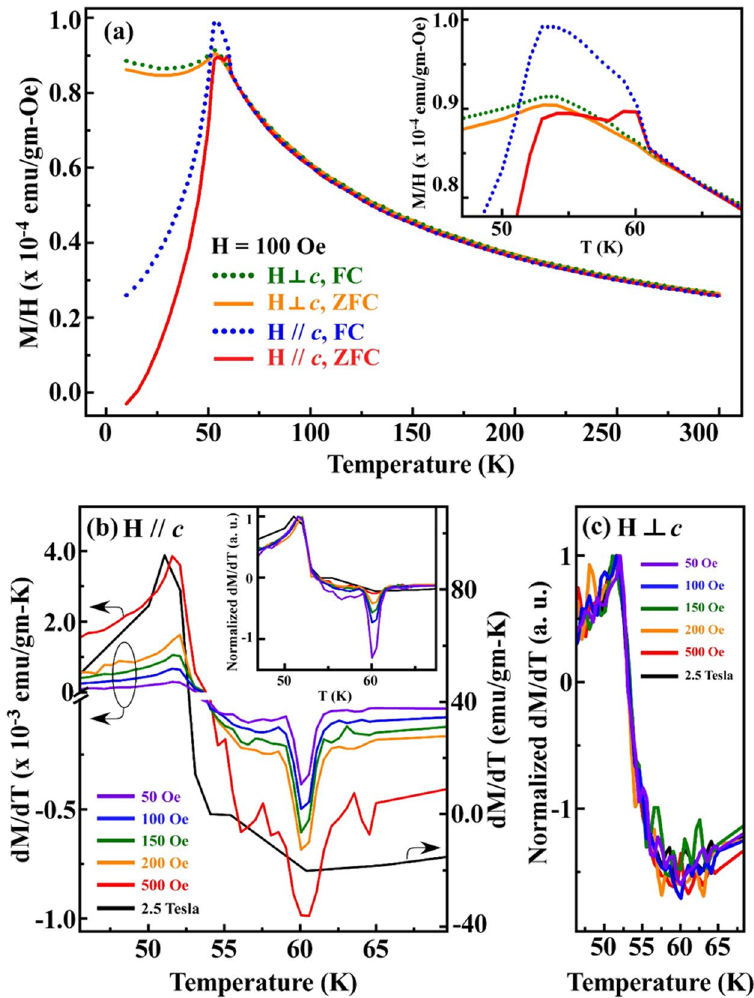
Figure 3. ( a ) Magnetic susceptibility (M/H) vs. temperature plots for the NTO single crystal under an external magnetic field of H = 100 Oe, applied parallel and perpendicular to the crystallographic c -axis. The inset shows an expanded view of the 47–67 K region, which includes a weak shoulder-like feature close to T SO (~60 K) in both FC and ZFC modes when the magnetic field is applied parallel to the c -axis. ( b ) Derivative of magnetization (M) versus temperature (T) plots for H// c at various magnetic fields to provide a better view of the feature close to T SO . The dM/dT plot at the 2.5 T magnetic field correspond to the right axis, whereas the dM/dT plots at weaker magnetic fields correspond to the left axis, as shown by the arrows. The inset shows the corresponding normalized dM/dT plots [(dM/dT)/(dM/dT at T = T N )]. ( c ) Normalized dM/dT plots for H ⊥ c